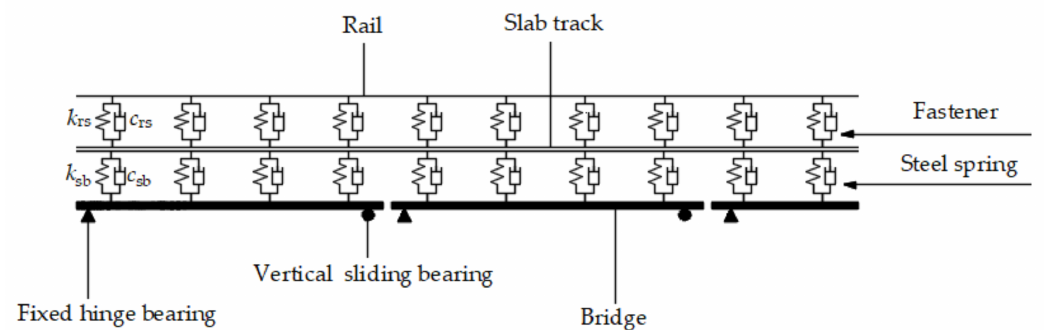
Figure 3. The mechanical model diagram of the China Railway Track System I type slab track on the bridge.